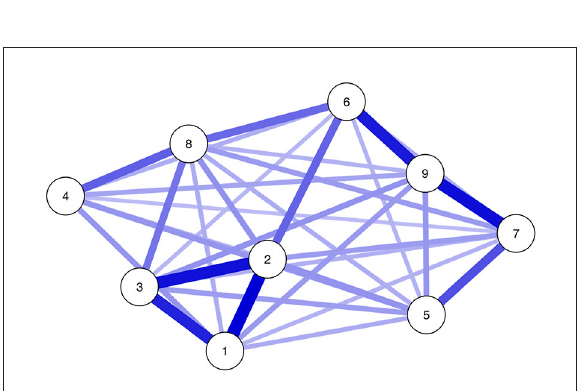
FIGURE2 Network model of the Social Media Disorder Scale. Node labels indicate items: 1 = Preoccupation, 2 = Tolerance, 3 = Withdrawal, 4 = Persistence, 5 = Displacement, 6 = Problem, 7 = Deception, 8 = Escape, and 9 = Conflict. Blue lines indicate positive edges (all edges all positive). Color shades indicate edge weights (stronger edges are darker, weaker edges are